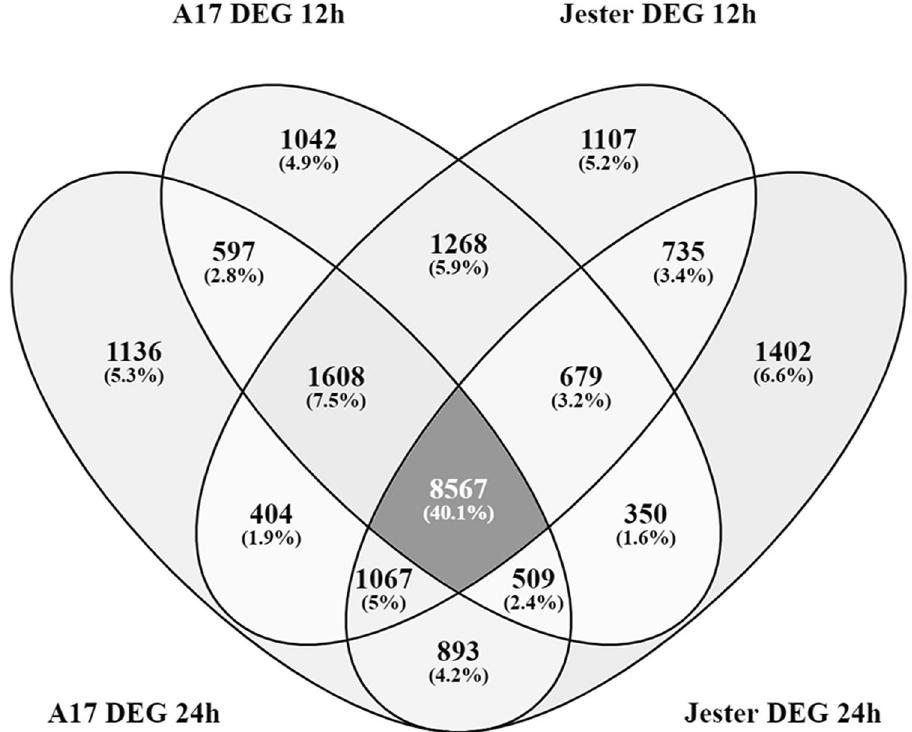
Figure 2. Venn diagram of differentially expressed genes in M. truncatula cultivars Jester and A17, 12 and 24 h post treatment (un-infested or SAA infested). Differentially expressed genes (DEGs) between the infested and non-infested control for a given cultivar and time point are compared. A core set of 8,567 genes (40%) are regulated in response to SAA feeding irrespective of the genotype (Jester and